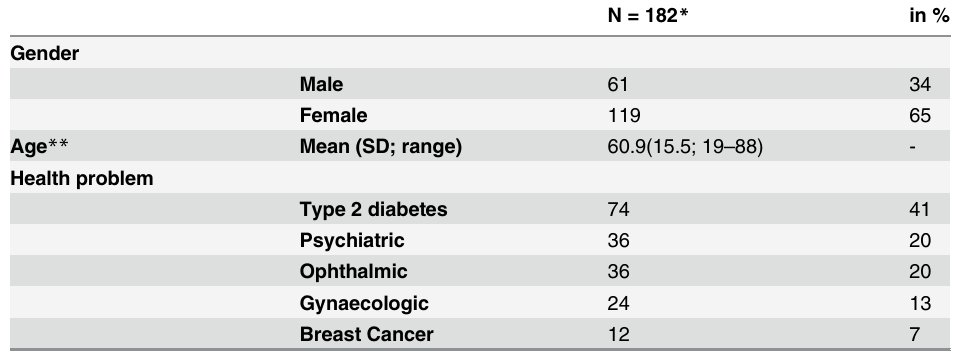
Table 1. Sample Characteristics of the